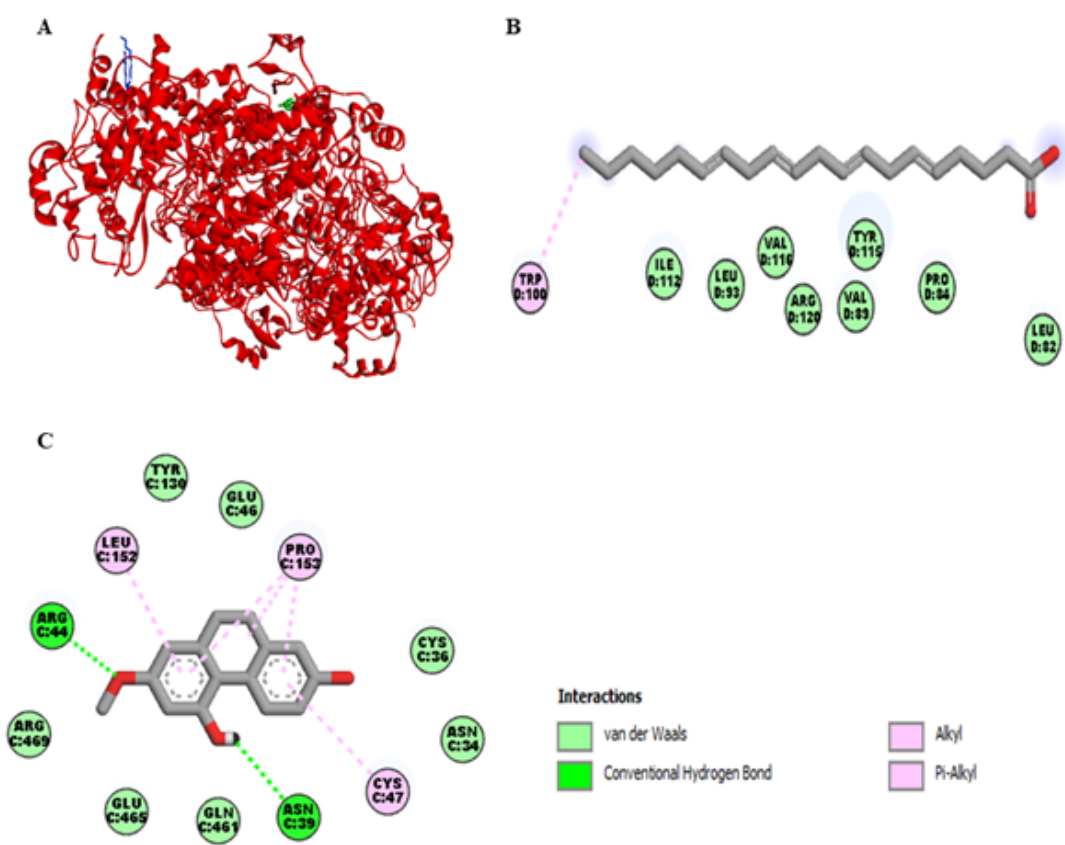
Figure 4. Docking lusianthridin into the COX-2 enzyme. ( A ) 3D interaction of arachidonic acid (blue) and lusianthridin (green) with the COX-2 enzyme. 2D interaction of binding modes for ( B ) arachidonic acid ( C ) lusianthridin inside the COX-2 enzyme.